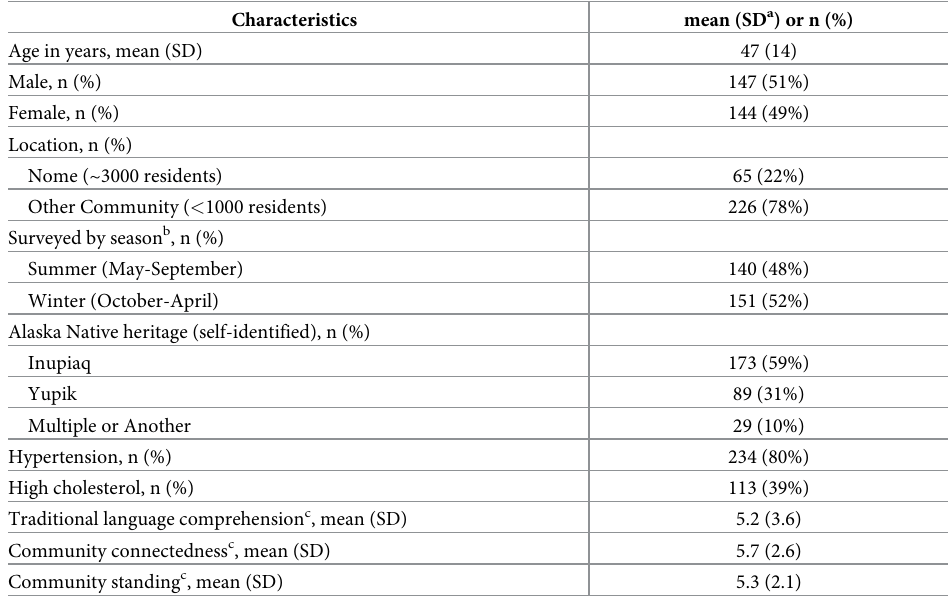
Table 1. Characteristics of participants (n = 291).